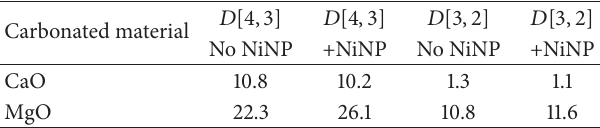
Table 4: Average particle size diameters, expressed as volume moment mean diameter ( 𝐷[4,3] ) and surface area moment mean diameter ( 𝐷[3, 2] ) of alkaline materials after one-hour carbonation experiments (S/L = 50 g/L), under mechanical mixing, with/without NiNP addition, determined by LD (all values expressed in 𝜇